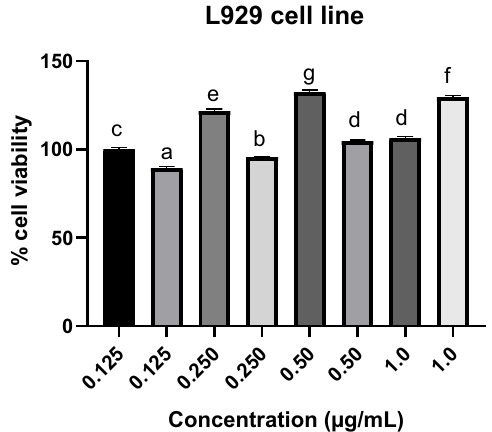
Figure 5: Cytotoxic e ff ect of extract and AgNPs@Org on Capan - 1 cell lines. The fi rst and second columns indicate the extract and nano - particles, respectively. Di ff erent letters indicated signi fi cantly dif - ferent ( p < 0.05 ) compared in each assay.